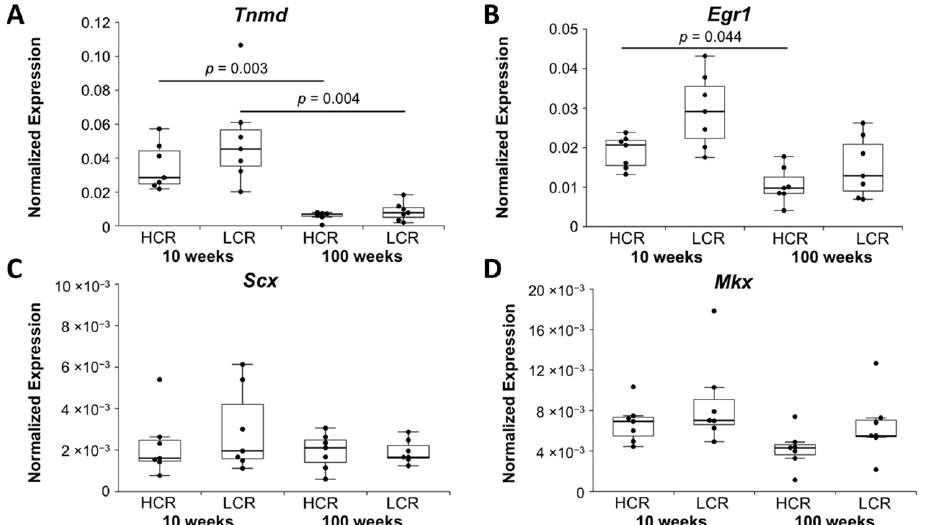
Figure 1. Normalized expression (NE) of tenocyte markers ( A ) tenomodulin, ( B ) early growth response 1, ( C ) scleraxis, and ( D ) mohawk. qRT-PCR data were normalized to the expression of the house keeping gene Rps18 . Results are shown as box plots with individual data points. Significant differences between two groups are marked as a line spanning between them with the p -value displayed above. p ≤ 0.05 was considered statistically